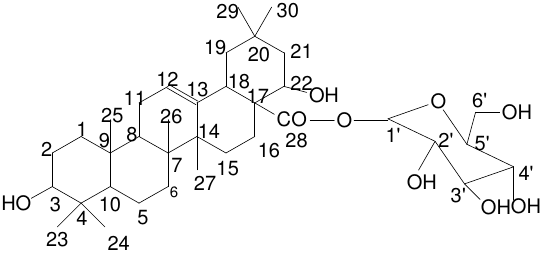
Figure 1. Olean-3 b , 22 b -diol-12-en-28 b -D-glucopyranoside-oic